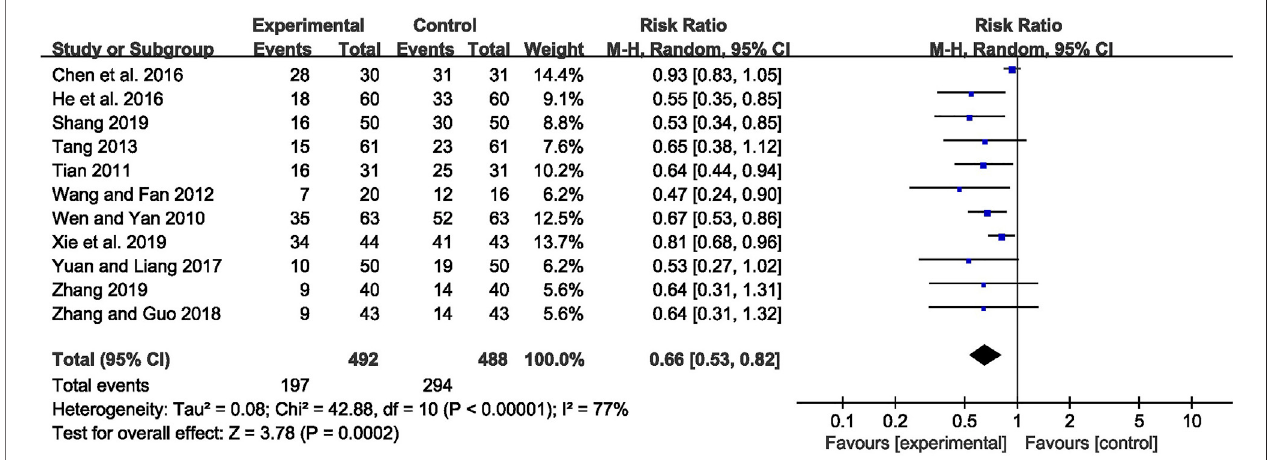
FIGURE 5 | Forest plot displaying the effects of CHM+AEDs vs. AEDs for abnormal rate of EEG in patients with IE.